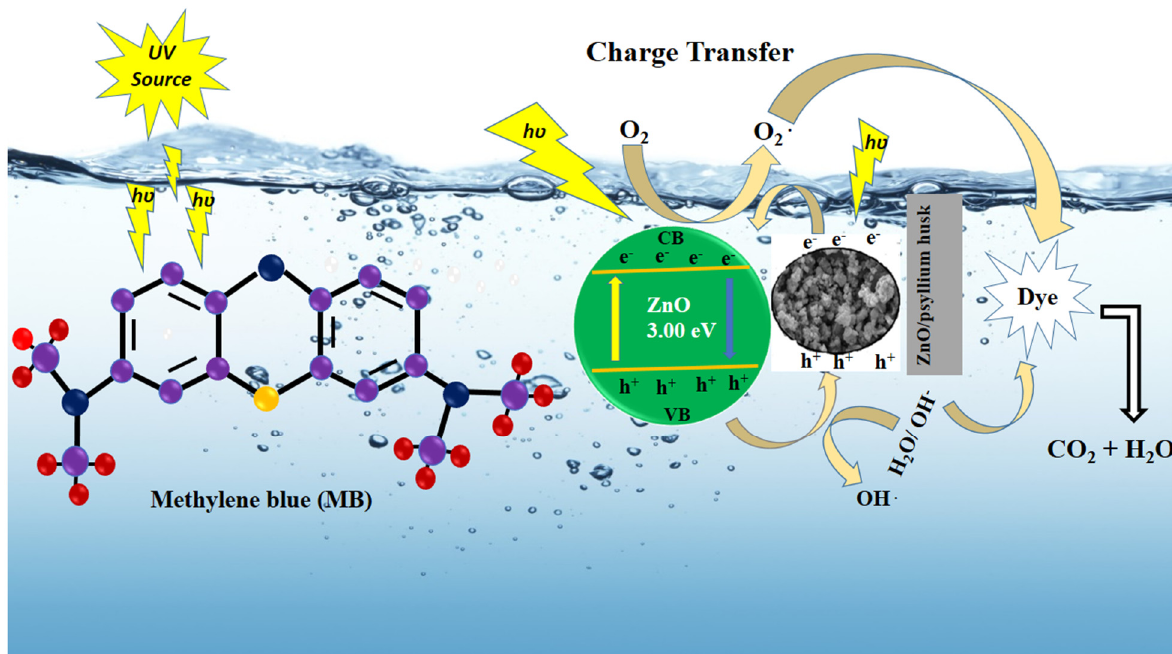
Scheme 2. Photodegradation mechanism on ZnO hybrid material produced from psyllium husk.